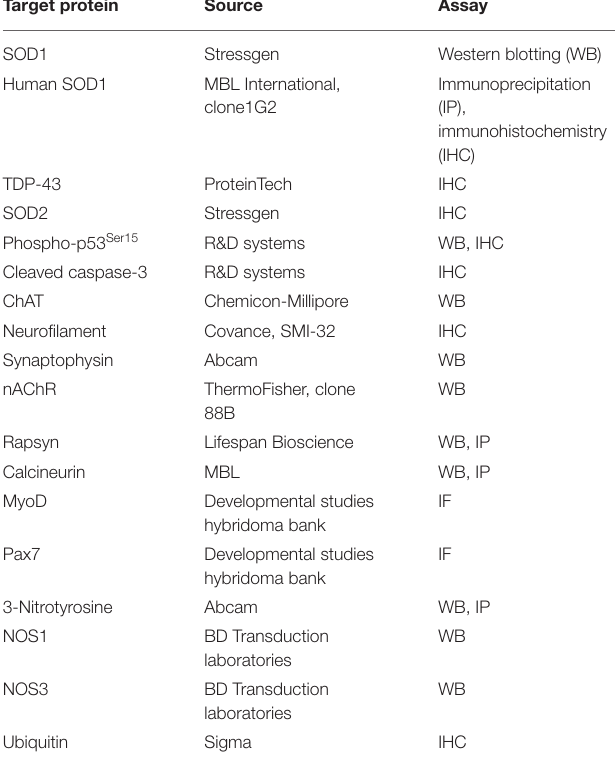
TABLE 1 | Primary antibodies